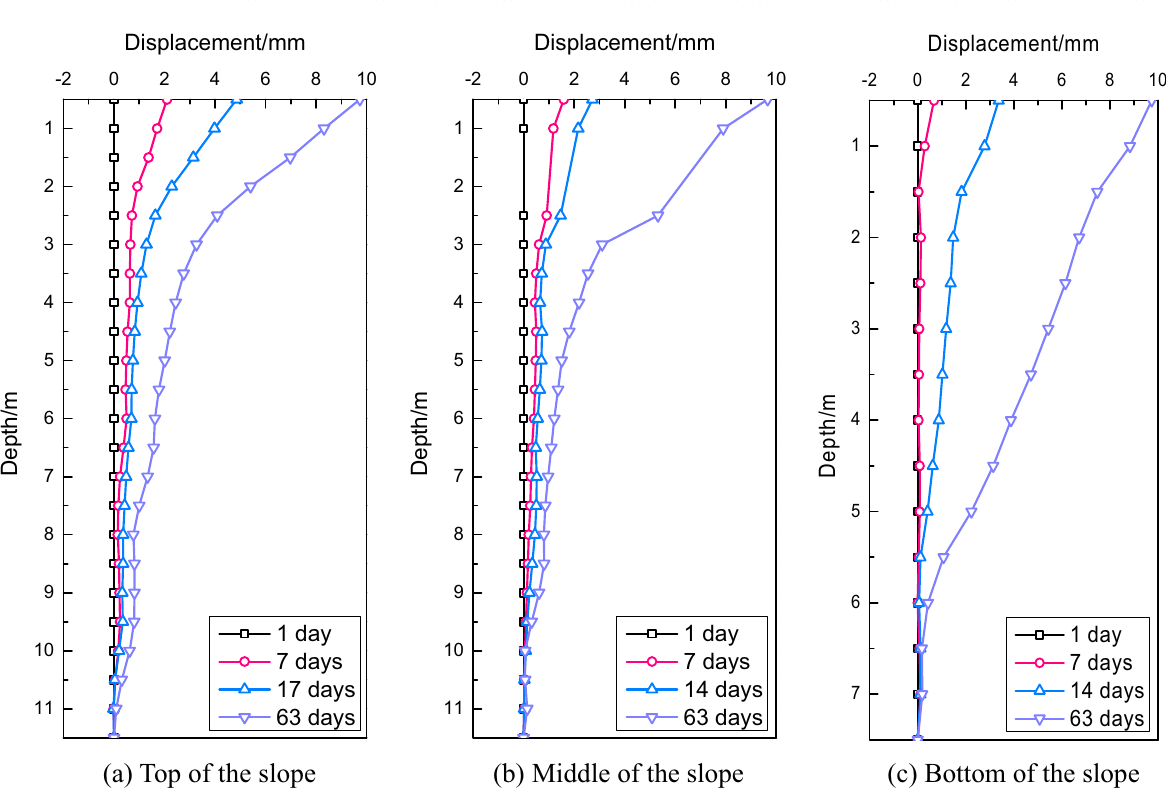
Figure 14. Slope displacements in the K2119 + 630